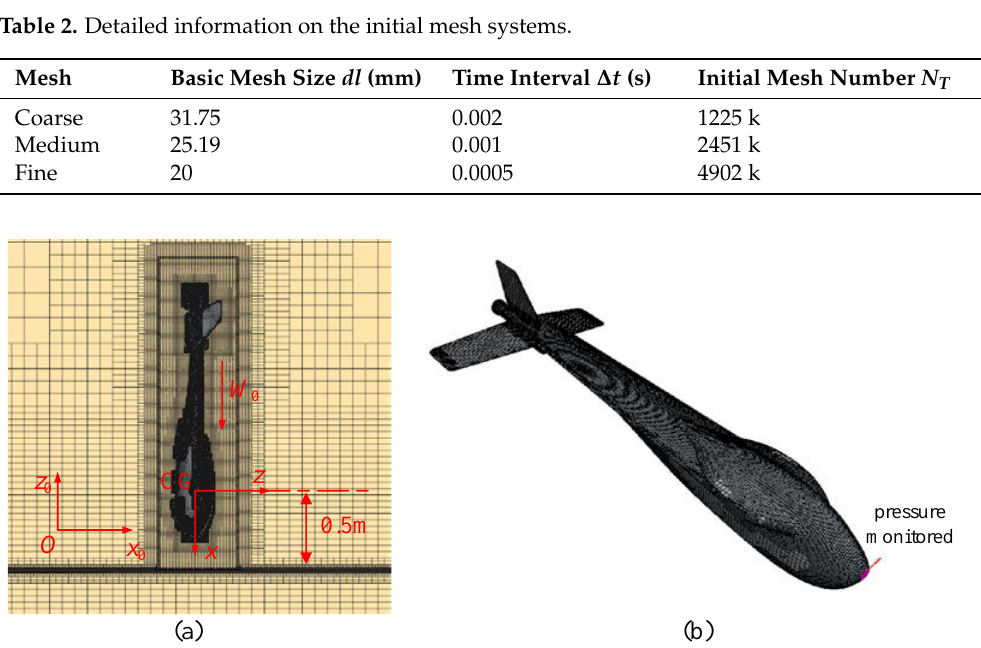
Figure 5. The sketch of CFD settings: ( a ) configuration of the boundary conditions; ( b ) mesh of computational domain.